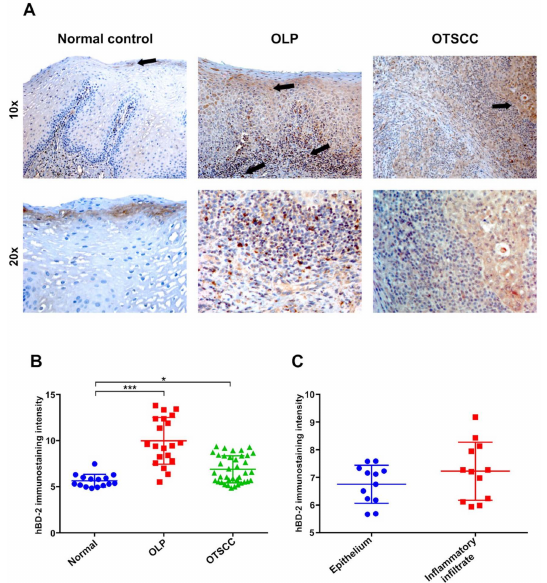
Figure 1. ( A ) Faint staining of human β -defensin 2 (hBD-2) in normal oral epithelium, which is more confined in the uppermost superficial layers (black arrow). Oral lichen planus (OLP) lesions exhibited strong epithelial and subepithelial hBD-2 expression. ( B ) In oral tongue squamous cell carcinoma (OTSCC) specimens, hBD-2 was also induced, but the staining was generally less intense than in OLP. ( C ) HBD-2 is equally expressed in the epithelial and subepithelial regions in OLP lesions. Data are expressed as means ± SD; n = 14, 14, and 40 for controls, OLP, and OTSCC, respectively; * p ≤ 0.05, *** p ≤ 0.001. Kruskal–Wallis test followed by Dunn’s multiple comparisons correction test ( B ) and Mann–Whitney U test ( C ) were applied.